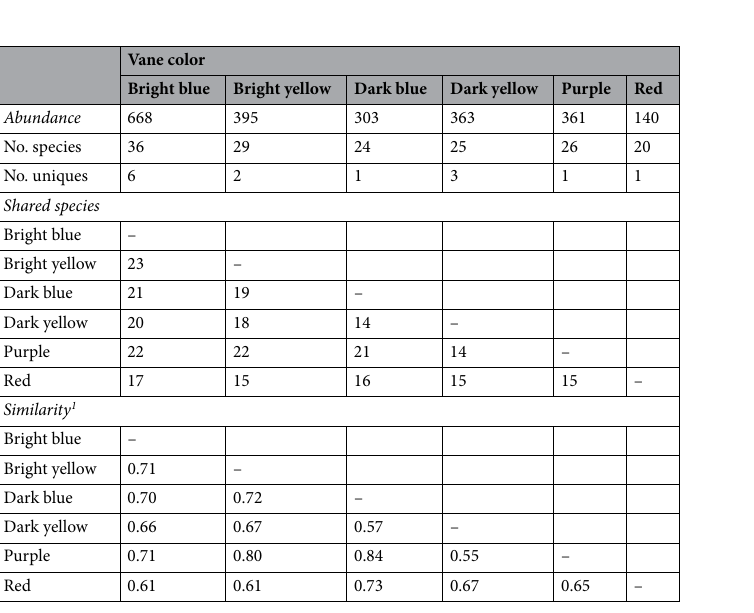
Table 2. A comparison of bee diversity and similarity measures among six colors of vane traps deployed in Arkansas livestock pastures. 1 Sorensen classic similarity indices.